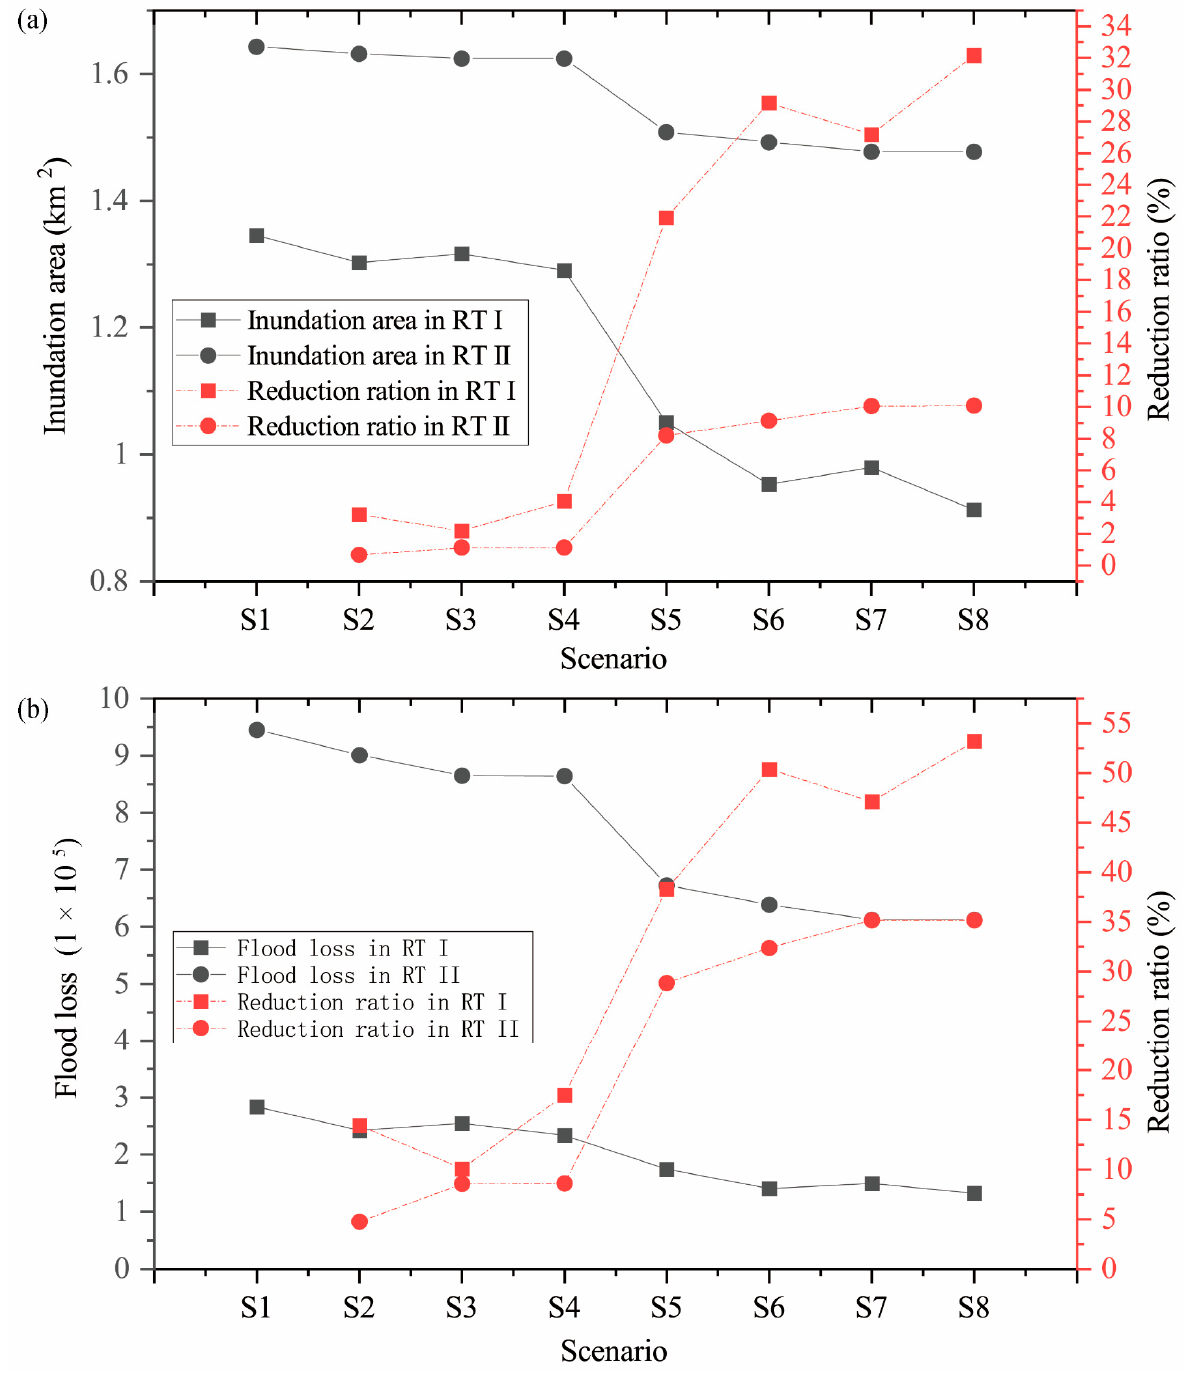
Figure 14. Evaluations of the flood disaster reduction effects of different intervention scenarios in the RT I and RT II conditions. ( a ) Index1: Inundation area; ( b ) Index2: Flood loss.